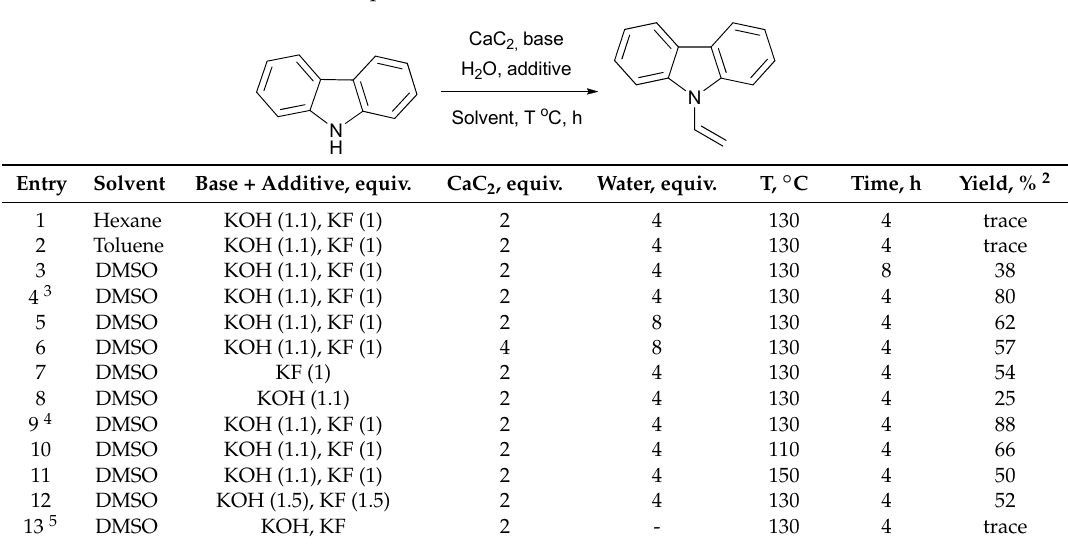
Table 1. Optimization of the reaction conditions. 1